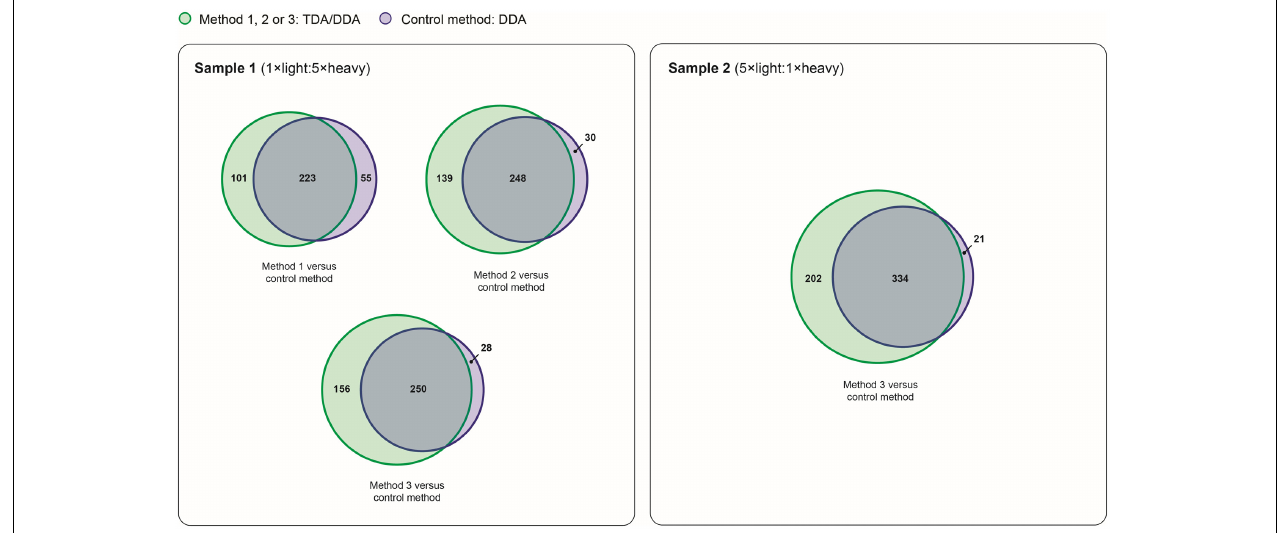
FIGURE 7 | Reproducibility of relative protein quantification in TDA/DDA and DDA control method experiments. Numbers of proteins quantified (from ≥ 2 heavy/light peptide pairs) across all three sets of technical replicates in TDA/DDA and DDA control method experiments conducted on sample 1 (left) and sample 2